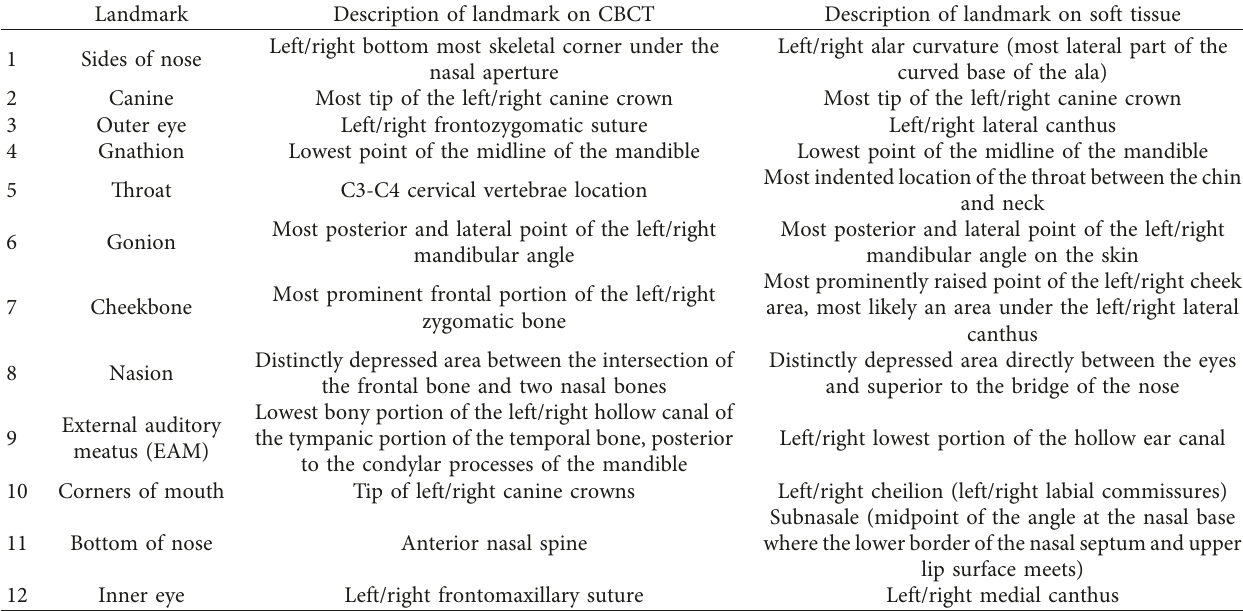
Table 2: Definition of landmarks used for measuring specific distances, depending on the imaging modality used.